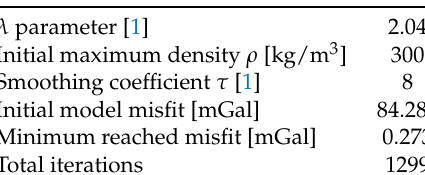
Table 5. Configuration of the gravimetric inversion parameters for the S model.